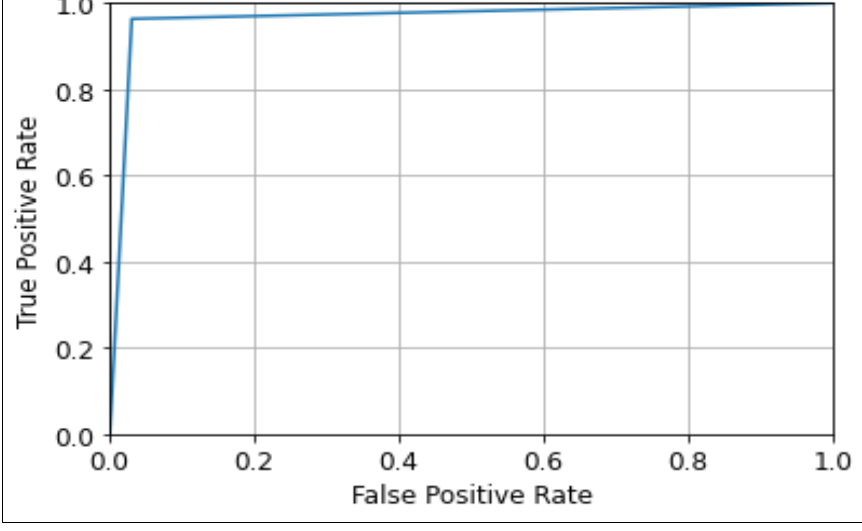
Figure 14. ROC Curve of MobileNetV2 model.